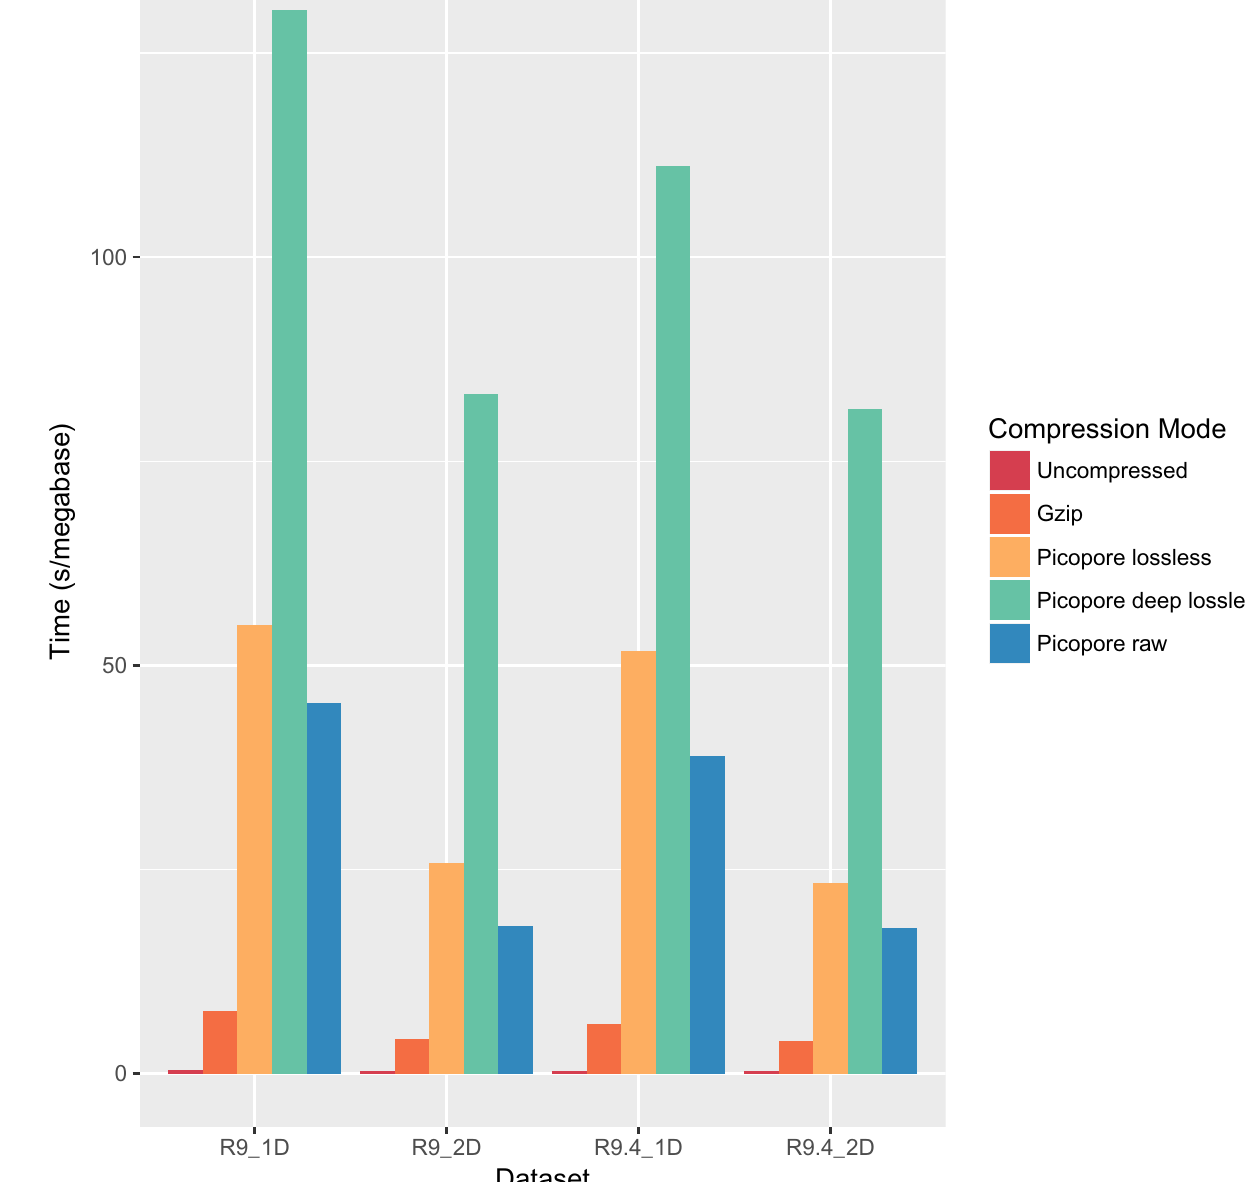
Figure 2. Time taken for single-thread compression and tarring of FAST5 files using various